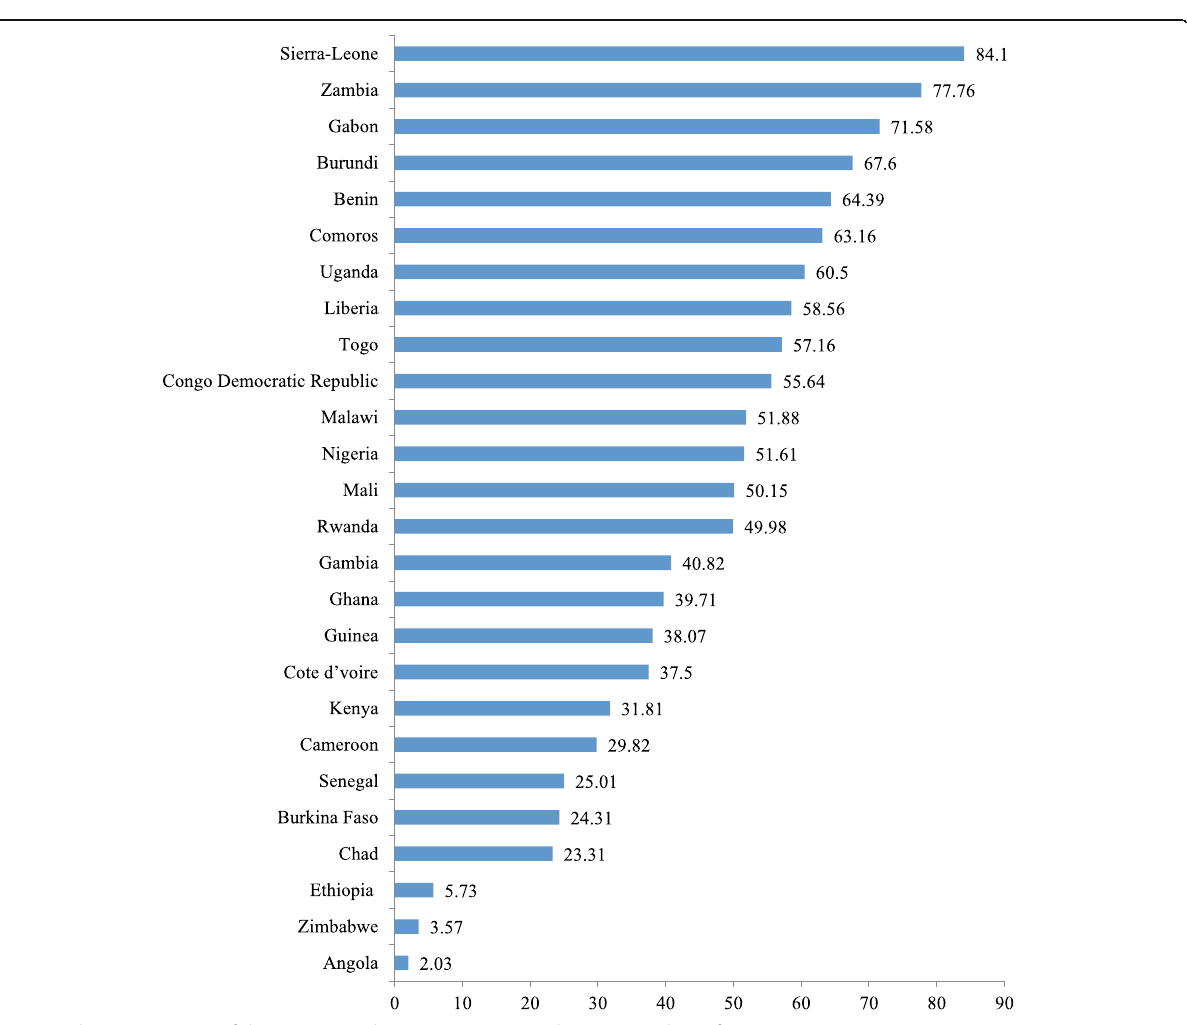
Fig. 1 Utilization coverage of deworming medication among married women: evidence from 25 SSA countries